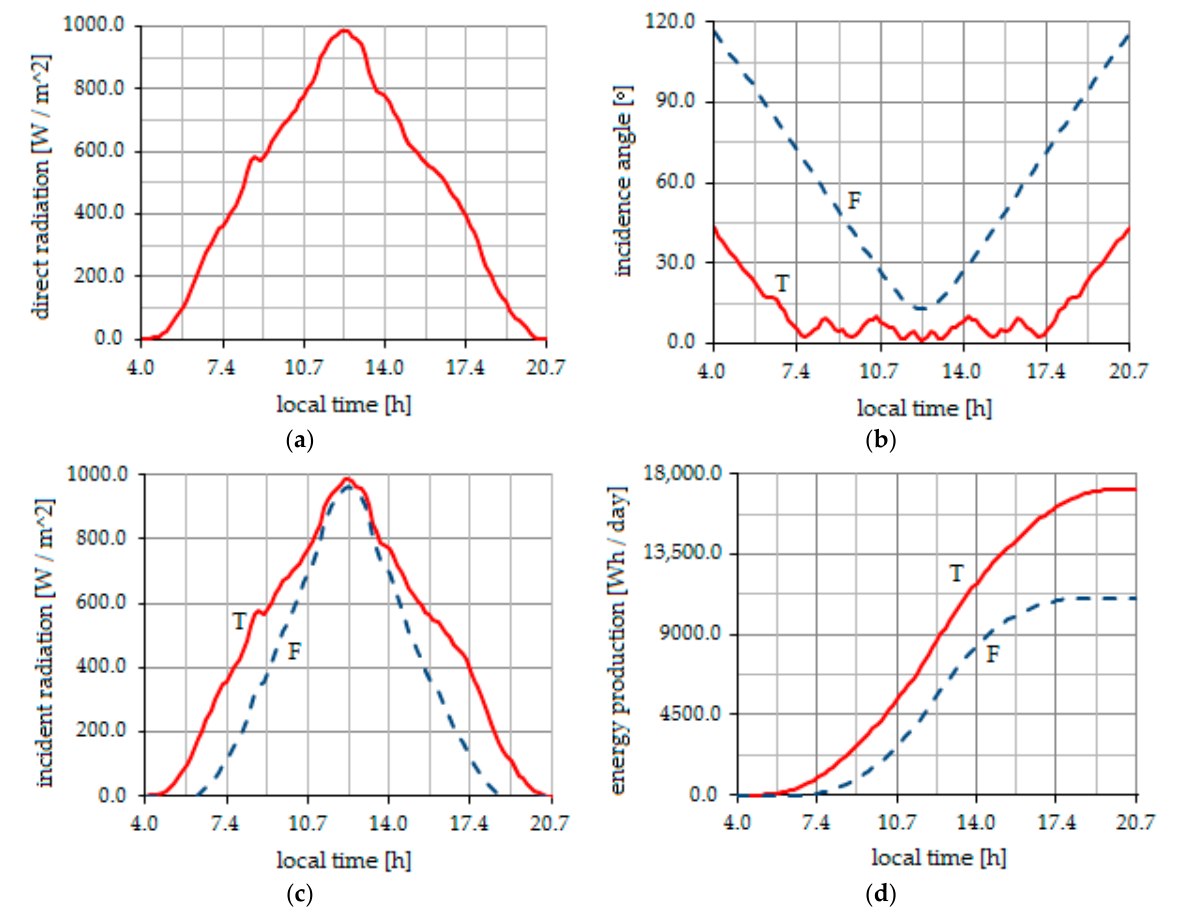
Figure 18. Results based on experimentally obtained weather data: ( a ) Direct radiation; ( b ) Angle of incidence; ( c ) Incident radiation; ( d ) Produced energy.